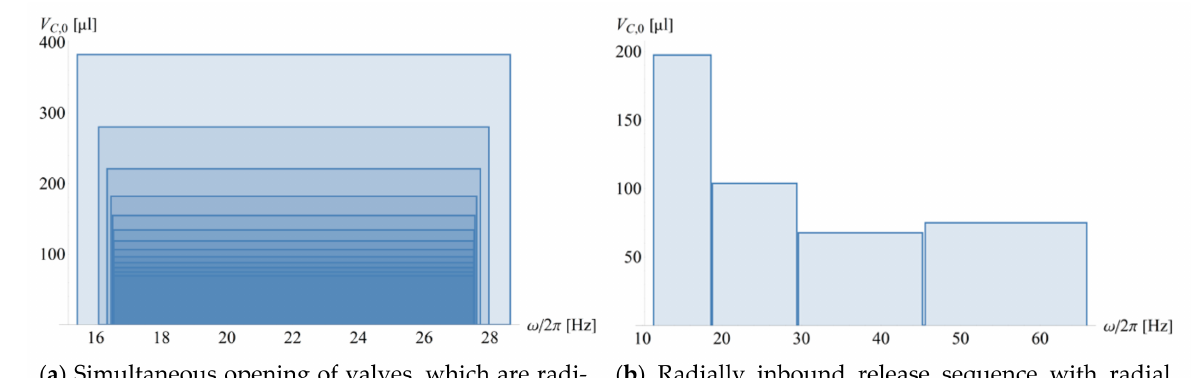
(Figure 4) through adjusting the main volume of the compression chamber V C,0, i , j . Note that the requirement to create non-overlapping bands Ω ± M · ∆Ω for serial opening even leads to a slight increase in V C,0 towards the highest spin rate ω (Figure 5b), and a huge widening of frequency bands Ω ± M · ∆Ω in the radially outbound release sequence (Figure 5d).